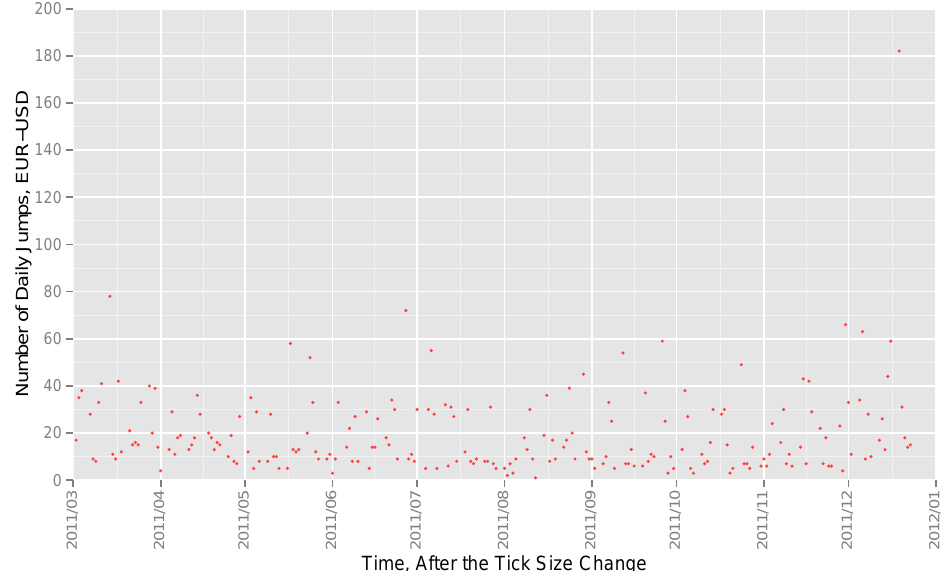
Figure 4. Daily Number of Jumps of EUR/USD, After Tick Size